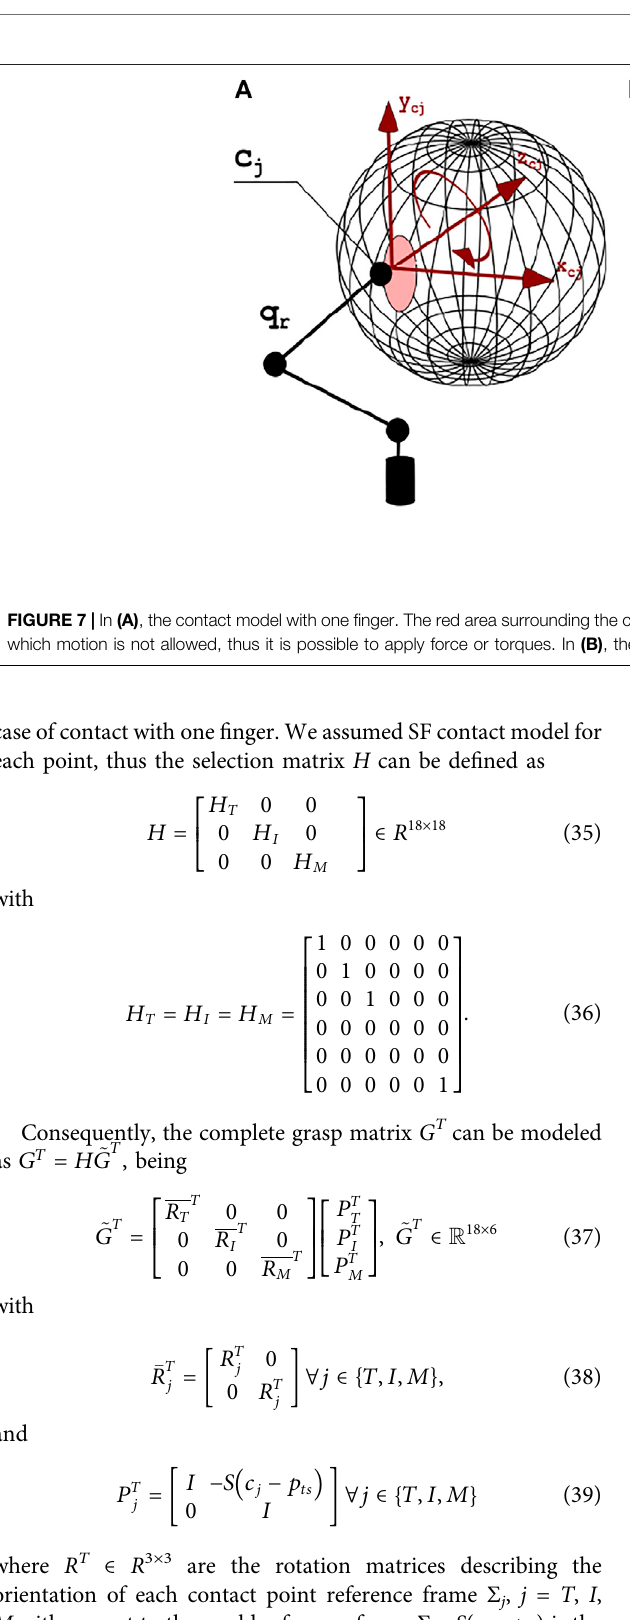
Frontiers in Robotics and AI |